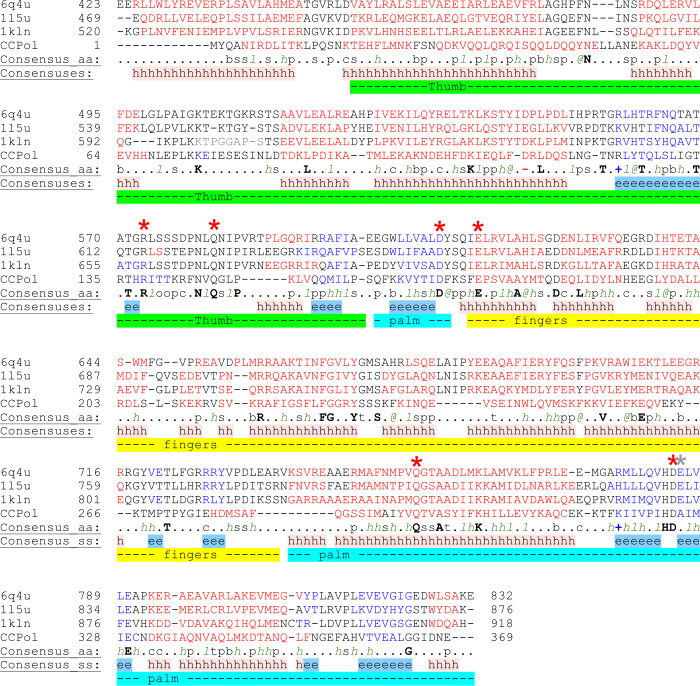
Structure-based sequence alignments of CCPol and the polymerase domains of several bacterial DNA Pol Is.The alignments were prepared using PROMALS3D multiple sequence and structure alignment server (Pei et al., 2008). The following protein structures were used for the alignments: 6q4u - Thermus aquaticus Taq polymerase residues 423–832; 1l5u - Geobacillus stearothermophilus DNA Pol I residues 469–876; and 1kln - E. coli DNA Pol I residues 520–918. A structural model of CCPol was prepared with I-Tasser (Yang et al., 2015). The polymerase sequences corresponding to the exonuclease domains absent from CCPol were removed from the alignment. The sequences are colored as follows: red – alpha helix, blue – beta strand, gray –E. coli Pol I thumb residues disordered in the structure used. Consensus amino acids are shown in below the structure, with conserved amino acids in bold and uppercase; aliphatic residues (I, V, L): green l; aromatic residues (Y, H, W, F): green @; hydrophobic residues (W, F, Y, M, L, I, V, A, C, T, H): green h; alcohol residues (S, T): o; polar residues (D, E, H, K, N, Q, R, S, T): p; tiny residues (A, G, C, S): t; small residues (A, G, C, S, V, N, D, T, P): s; bulky residues (E, F, I, K, L, M, Q, R, W, Y): b; positively charged residues (K, R, H): blue +; and charged residues (D, E, K, R, H): c. Consensus secondary structures are marked with pink h for alpha helix and blue e for beta strand. Polymerase domains (Thumb, fingers, and palm) are marked underneath the alignment. Predicted mechanistically important residues are marked with red asterisks (with a grey asterisk marking a CCPol alanine residue which in other PolA-like polymerases is invariably a catalytic glutamic acid) above the sequence.